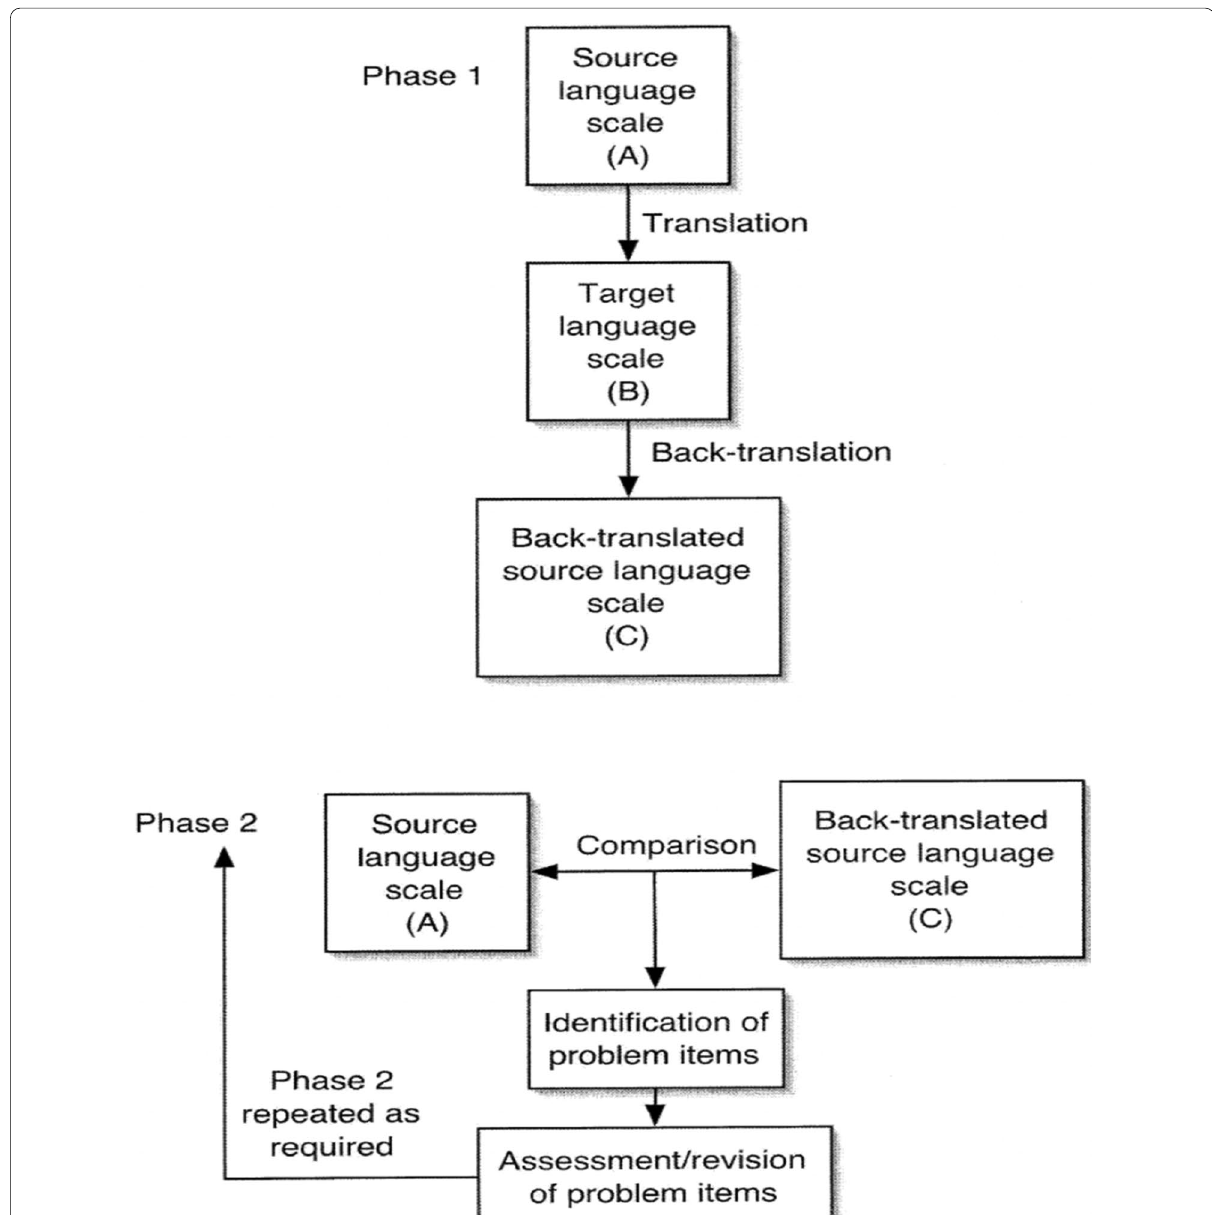
Fig. 1 Flow diagram of the translation (phase 1) and validation (phase 2)